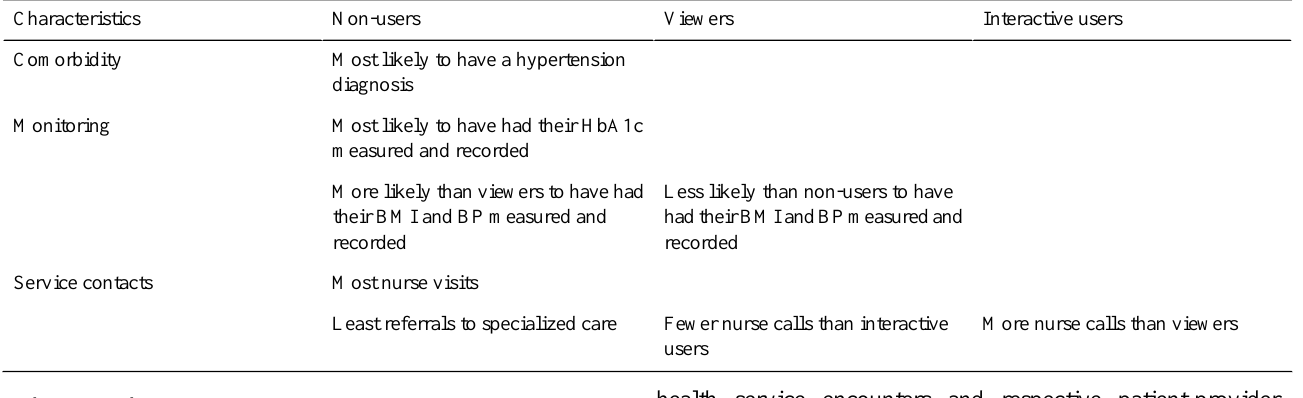
Table 4. Differences in patient characteristics between user